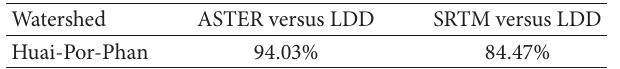
Table 4: Intersected area between various DEMs extracted in Huai- Por-Phan watershed.